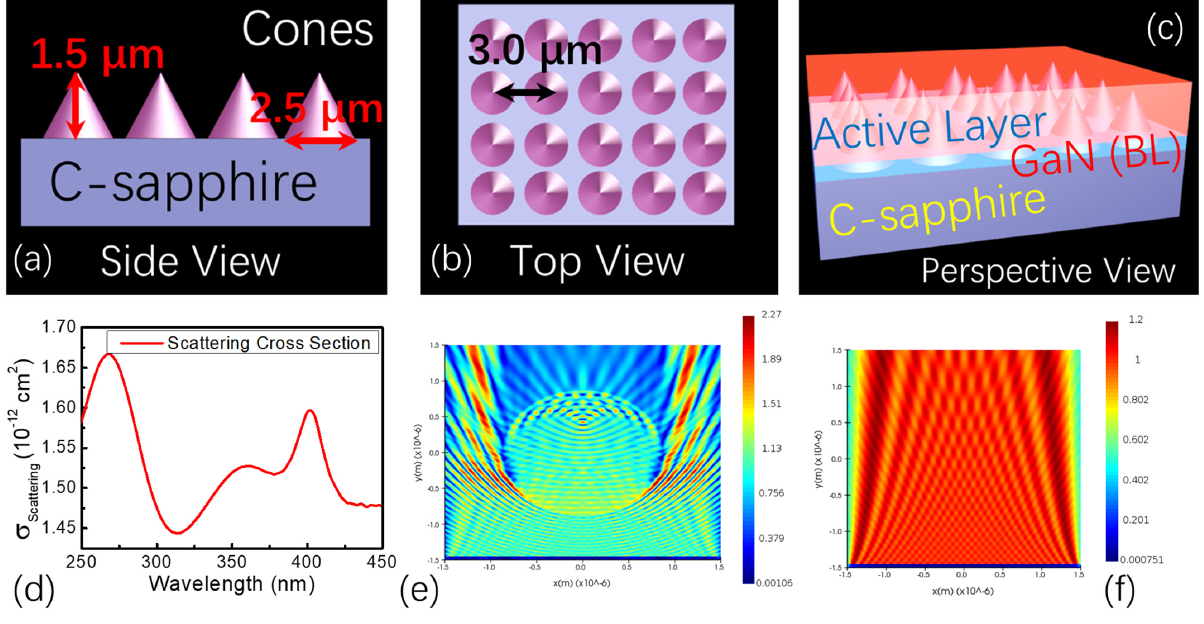
Figure 4. The schematic illustration of the undoped, Si-doped, and Mg-doped GaN thin films: ( a ) side view, ( b ) top view, ( c ) perspective view; ( d ) scattering cross-section of the thin films on hexagonal lattice arrangement patterned sapphire substrates calculated by using finite difference time domain method; electric field distribution in ( e ) the hexagonal lattice arrangement PSS and ( f ) FSS. To investigate the lasing properties of the samples, a nanosecond laser at 266 nm was used as the excitation source. When the pulse laser was irradiated on the undoped GaN thin films, the broadband photoluminescence spectra with a full width at half maximum (FWHM) of approximately 16 nm were obtained below the threshold, as seen in Figure 5a. As the laser pulse energy exceeded 170 μ J, an asymmetric photoluminescence spec- trum was observed and a sharp peak appeared at the top of the emission peak with a half- peak width of approximately 5 nm or narrower, indicating the formation of resonant ra- diative lasing emission. As shown in Figure 5b, the intensity of the lasing emission in un- doped GaN thin films increased dramatically once the pulse laser energy exceeded the threshold. Compared with the undoped GaN thin films, the lasing emission in the Mg- doped GaN exhibited a lower threshold of 69 μ J and a narrower FWHM of approximately 3 nm (refer to Figure 5c,d). However, no lasing emission and spectrum narrowing phe- nomenon could be observed in the Si-doped GaN thin films, as drawn in Figure 5e,f; the values of the FWHM became even larger at a higher pulse energy, followed by the slow- down in peak intensity enhancement. The peak center of the photoluminescence showed a blue shift from 406.7 to 401.3 nm and implied the existence of the migration of ions in the active layer with significant thermal losses. As the increasing energy of 266 nm